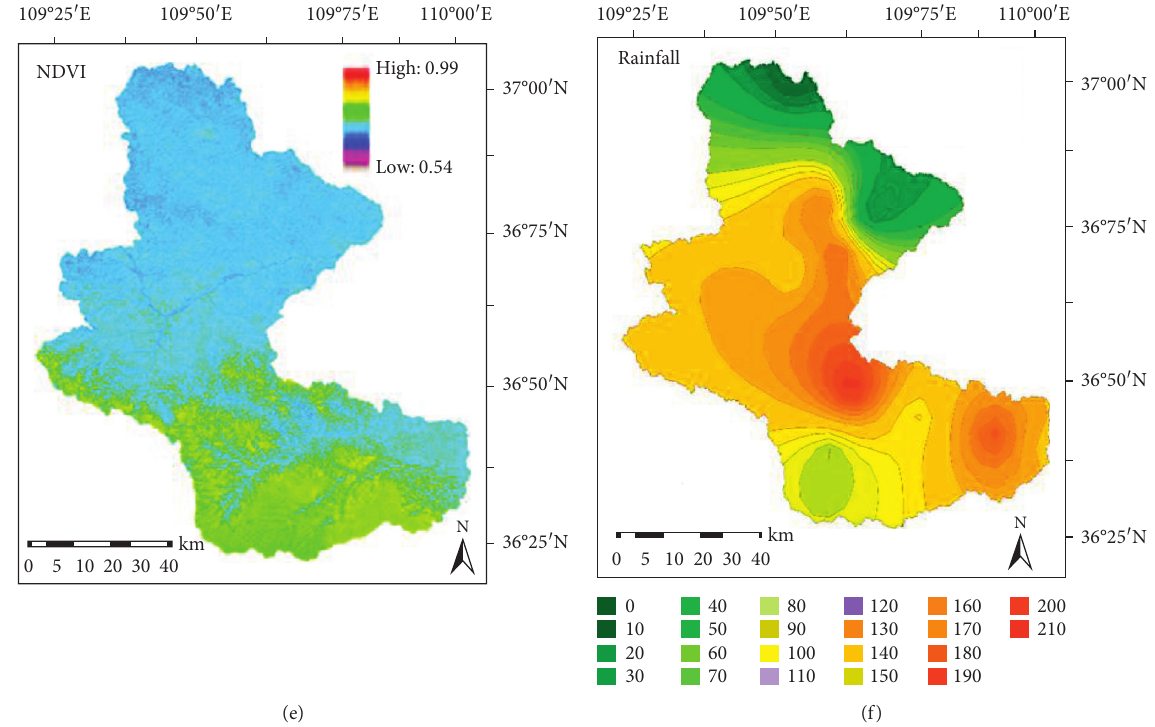
Figure 3: The thematic maps for factors: (a) elevation, (b) slope angle, (c) slope aspect, (d) profile curvature of the slope, (e) vegetation, and (f)